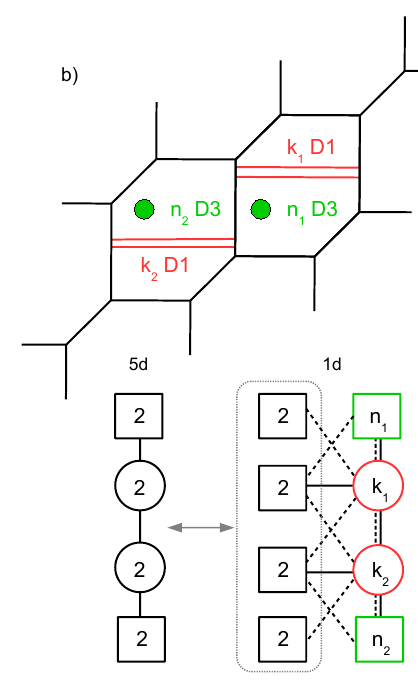
Figure 14 . a) Brane realization of the SU(2) 2